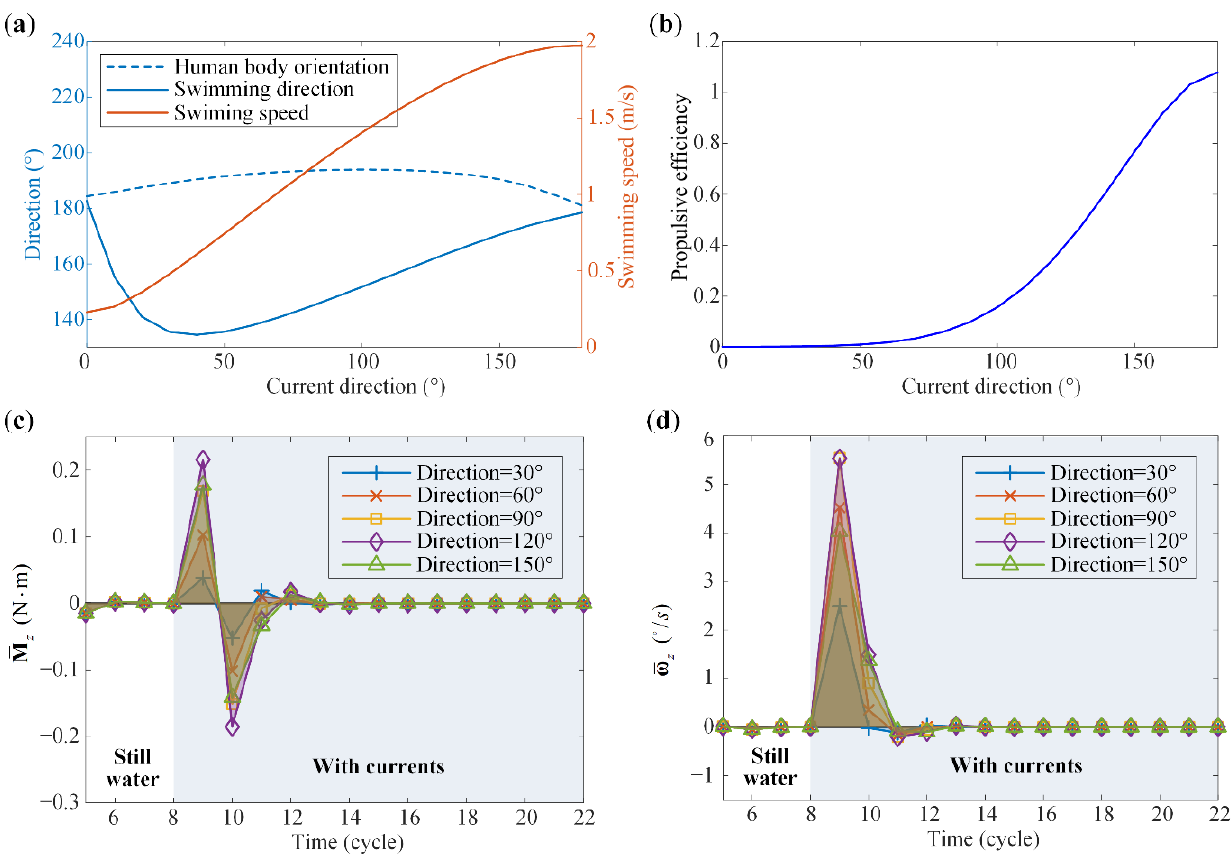
Figure 8. Analyses of the freestyle swimming performance under the currents (velocity = 1 height/cycle) with variable direction (Case II). ( a ) Evolution of the human body orientation, swimming direction, and swimming speed with respect to the current direction. ( b ) Evolution of the propulsive efficiency with respect to the current direction. ( c ) The average fluid moment per cycle applied to the human body about the global z axis ( M z ) at different current directions. ( d ) The average angular velocity of the human body per cycle about the z axis ( ω z ) at different current directions.